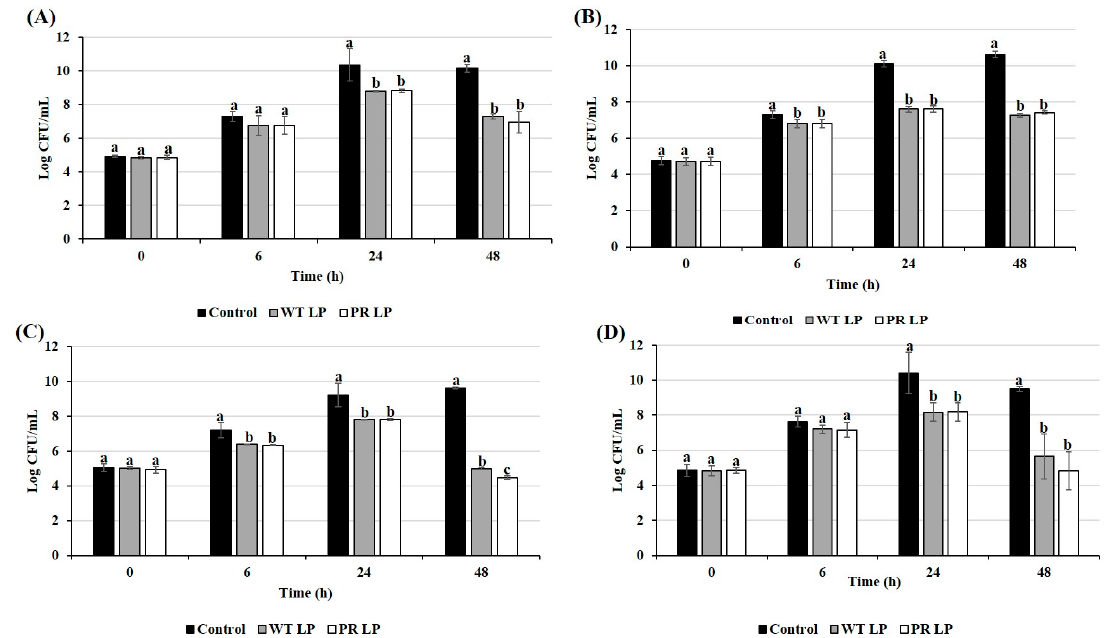
Figure 2. Growth inhibition of S. Typhimurium ( A ), enterohemorrhagic Escherichia coli (EHEC) ( B ), S. aureus ( C ), and L. monocytogenes ( D ) in co-culture of wild-type LP and LP +PR strains at 0, 6, 24, and 48 h. Error bars indicate standard deviation from 6 parallel trials. Different letters (a–c) at each time point indicate the significant growth reduction when compared to control at P < 0.05.